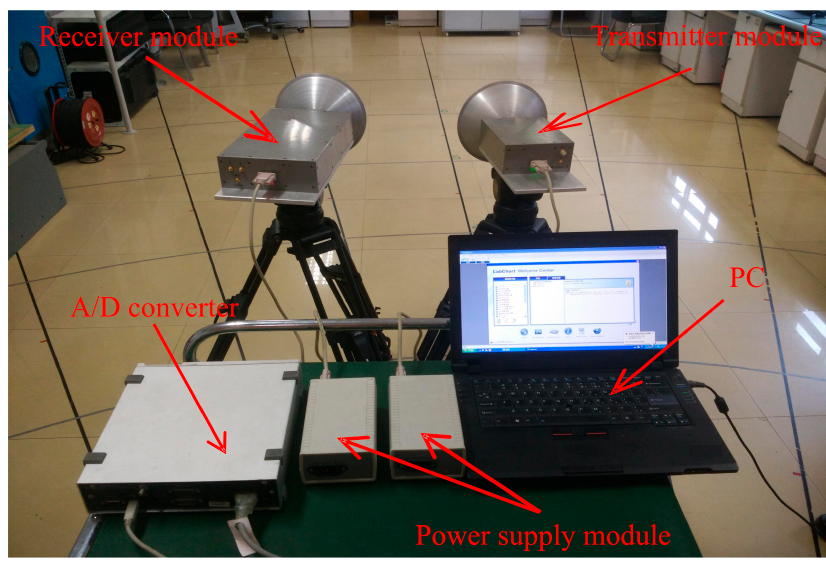
Figure 1. Photograph of the 94-GHz radar measurement system.